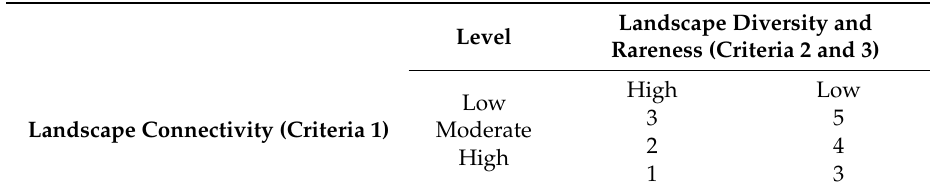
Table 1. Functional scores for the evaluation of the landscape grid cells according to the determined criteria for mapping the landscape potential (LP).